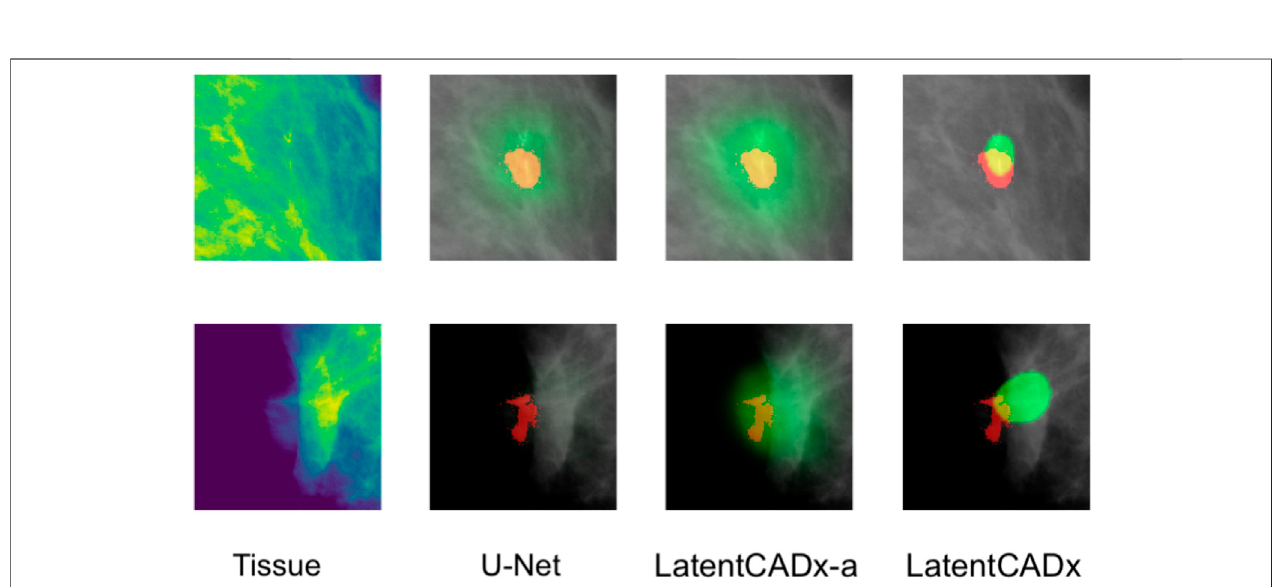
FIGURE9| IncompleteAnnotationsGround-truthsegmentationswhichdonotappeartocomprehensivelycapturetheregionofinterestandsegmenteddifferently by LatentCADx (Mammograms obtained from (Lee et al., 2006); CC BY open access license).